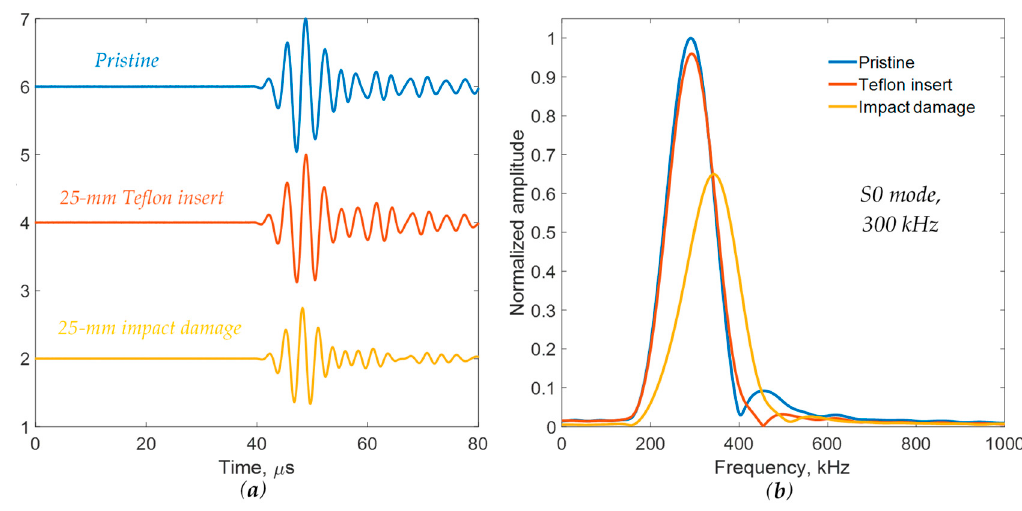
Figure 23. Signal comparison between the pristine area, the Teflon insert, and the impact damage using pure S0 mode at 300 kHz on a 3-mm quasi-isotropic composite plate: ( a ) time-domain signals; ( b ) frequency spectrums.